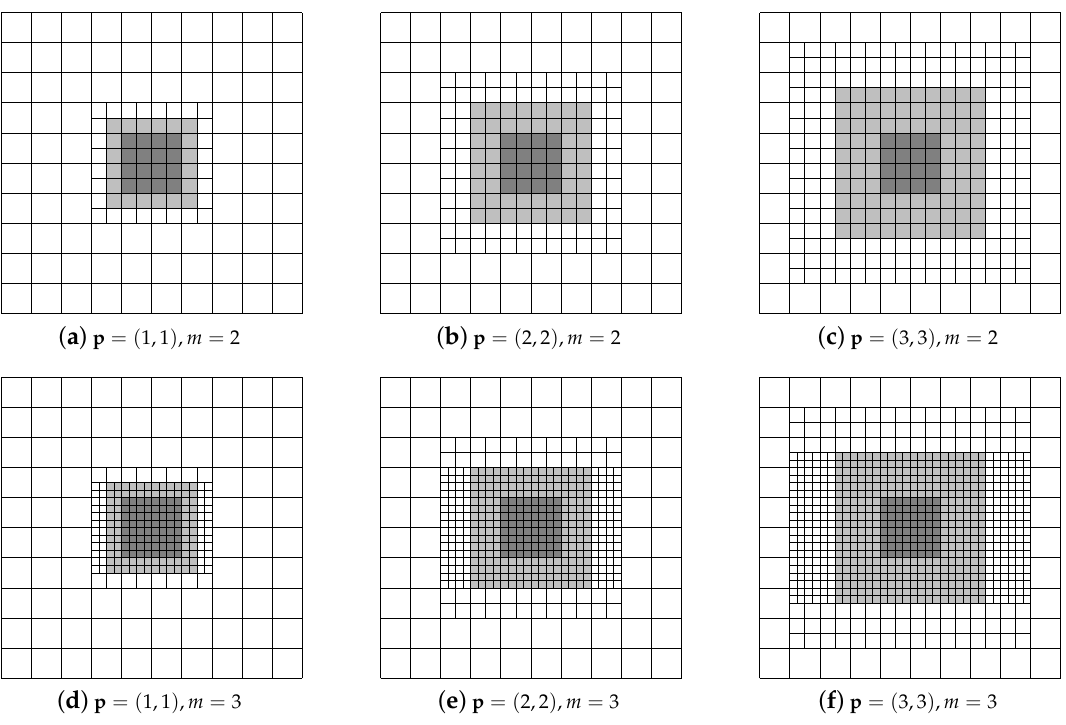
Figure 1. The domains ω 1 H and ω 1 T are highlighted in dark gray and light gray, respectively, for different mesh